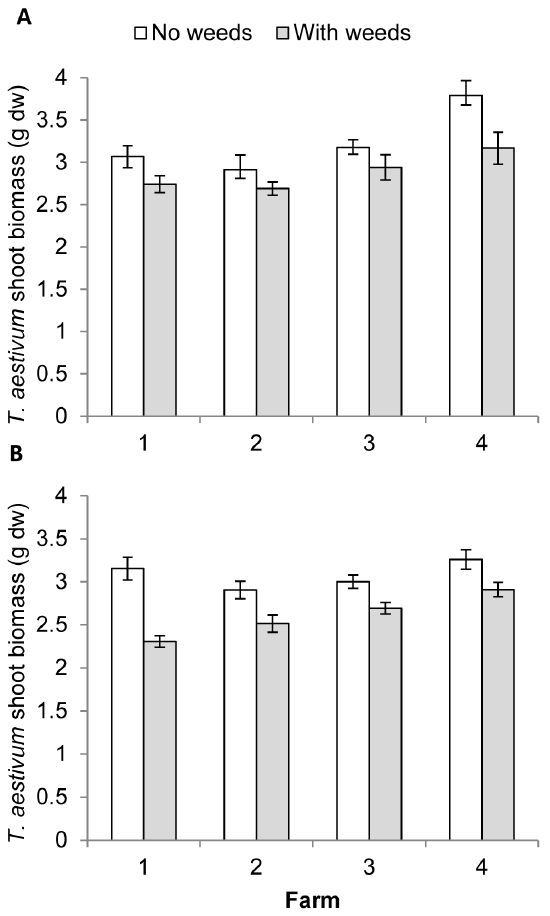
Figure 2. Competition interacts with inoculation effects. Shoot biomass of Triticum aestivum (mean 6 SE) growing in soil with or without weeds. A growing in sterilized soil, B growing in inoculated soil.